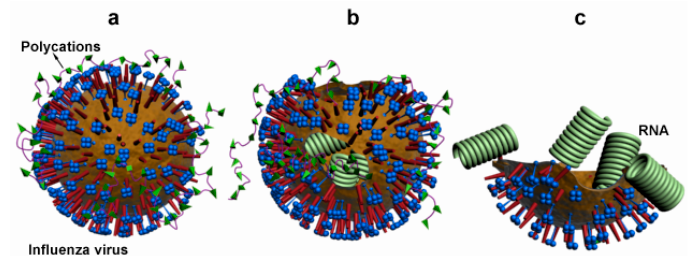
Figure 7. Cartoon depicting the procedure of inactivation of influenza virus by quaternized pyridinium-type polyvinylpyrrolidone: ( a ) adsorption of polycations onto the surface of viral particle; ( b ) penetration of polycations into the lipid envelope followed by envelope damage; and ( c ) leakage of the viral RNA accompanied by virostasis.